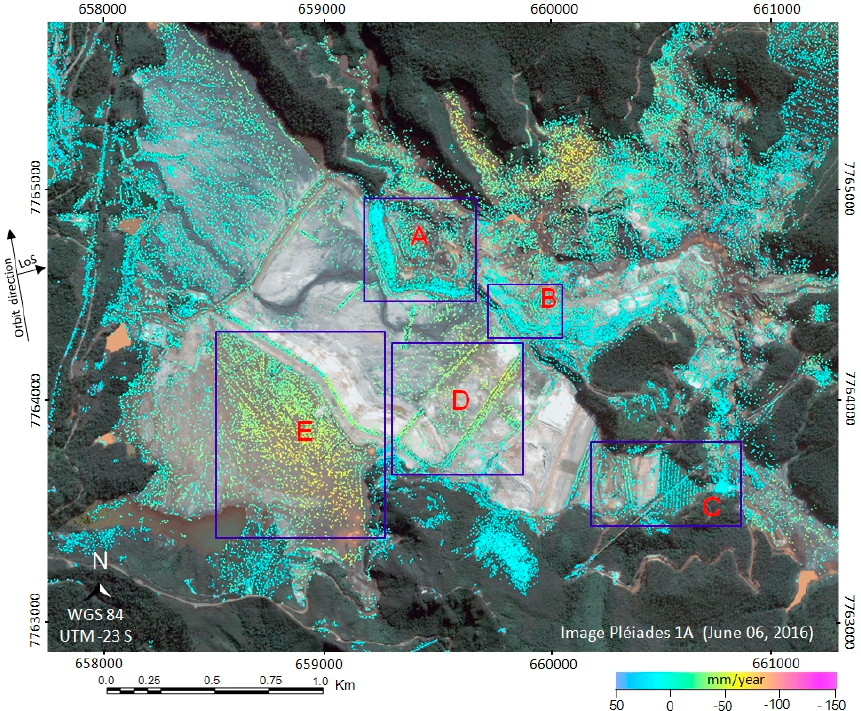
Figure 8. Ground displacement map in LoS of the Germano reservoir derived from the PSI analysis.